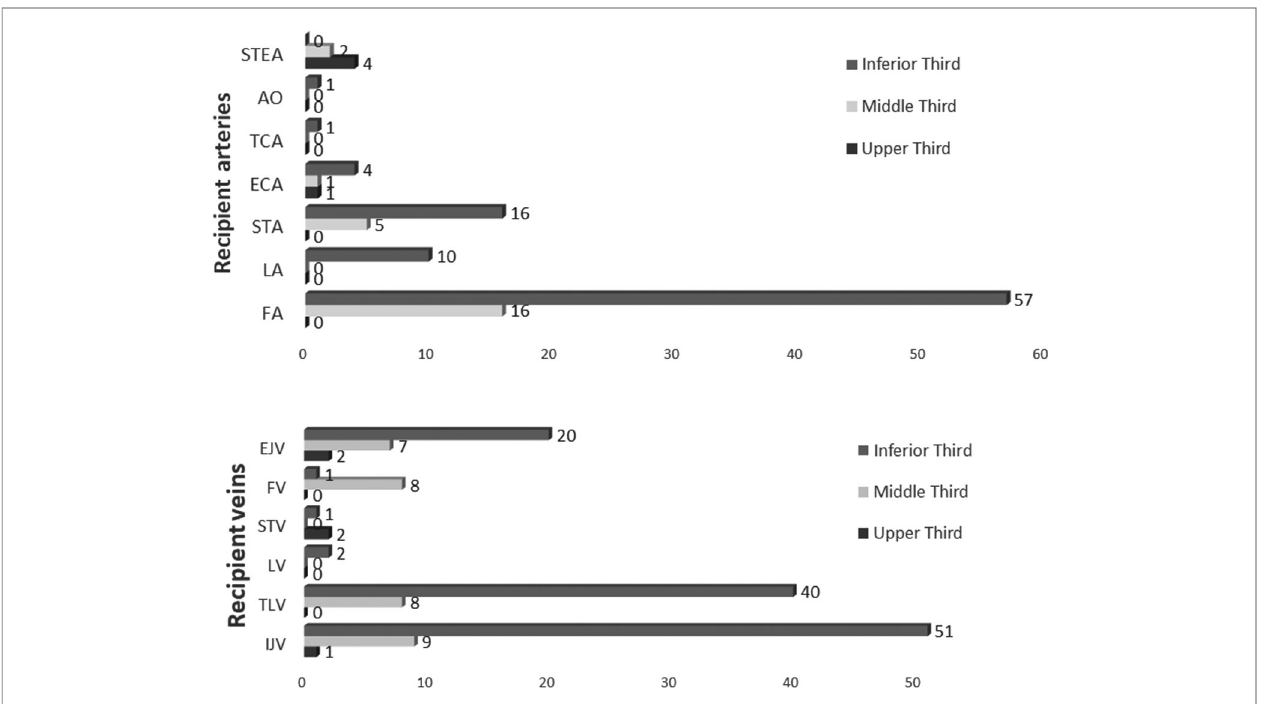
FIGURE 3 | Recipient vessel choice for each facial third reconstruction. STEA, super fi cial temporal artery; AO, occipital artery; TCA, transverse cervical artery; ECA, external carotid artery; STA, superior thyroid artery; LA, lingual artery; FA, facial artery; EJV, external jugular vein; FV, facial vein; STV, super fi cial temporal vein; LV, lingual vein; TLV, thyro-linguo-facial trunk; IJV, internal jugular